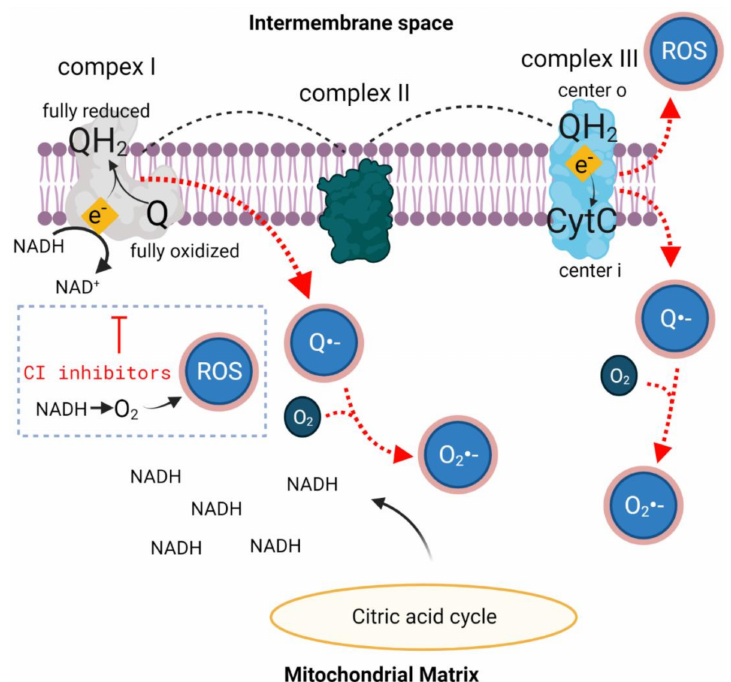
Figure 2. Semiquinone and ROS formation in complex I and complex III. The electron transport chain begins with the arrival of NADH to complex I from the citric acid cycle. NADH gives its electrons to ubiquinone (Q), which is the first electron carrier. This electron transfer can yield an either fully reduced ubiquinol (QH 2 )—the favorable outcome, or a semi reduced semiquinone (Q •− )—the ROS outcome. At complex III, electron transfer between QH 2 and the next electron carrier, cytochrome C (CytC), can also result in the fully reduced CytC or Q •− . These redox reactions can yield ROS when homeostatic conditions change. Since NADH is a redox-ready molecule, it has a high potential to reduce other molecules in its surroundings. In the situation when complex I’s NADH binding site is occupied, especially when complex I inhibitors are used and there is a large pool of NADH arriving from the citric acid, NADH and O 2 could react to create ROS. A plethora of O 2 in the tissue, such as in HBOT, can increase interaction between O 2 and redox-ready molecules such as NADH or Q •−